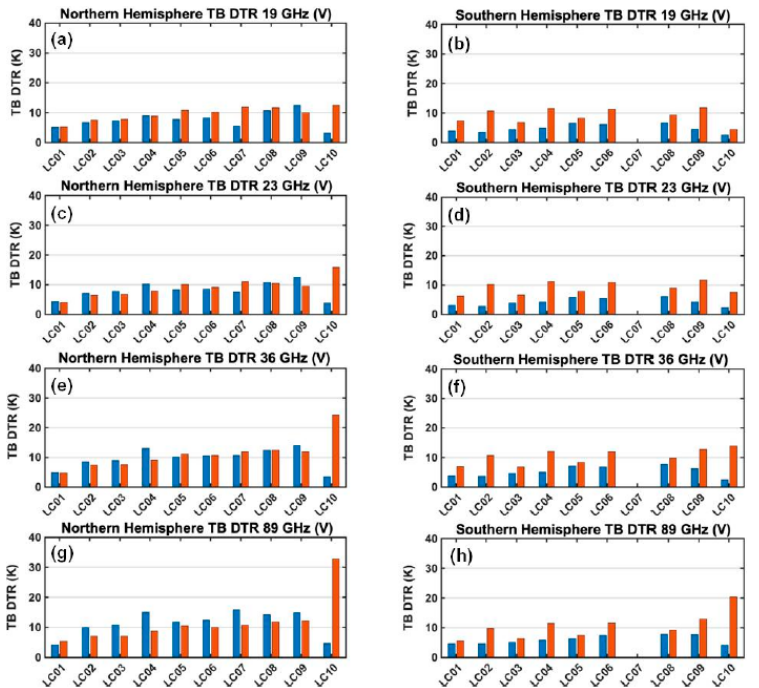
Figure 9. Mean monthly DTR averaged over different land cover types for two contrasting seasons of January 2016 and July 2016 for the ( a , c , e , g ) Northern Hemisphere, and the ( b , d , f , h ) Southern Hemisphere at ( a , b ) 19 GHz vertical polarization, ( c , d ) 23 GHz vertical polarization, ( e , f ) 37 GHz vertical polarization, and ( g , h ) 89 GHz vertical